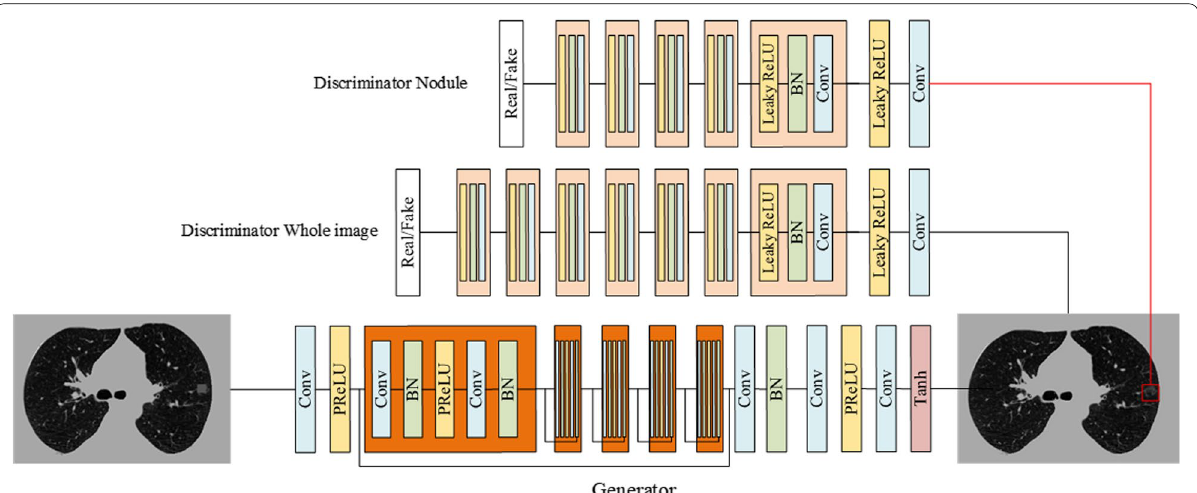
Fig. 2 The structure of the network. The generator creates the synthetic ground glass nodule at the position where the mask in the input. The generator is composed of convolutional layers with a kernel size of 3 activation function. The discriminator was composed of convolutional layers with a kernel size of 3 PReLU activation